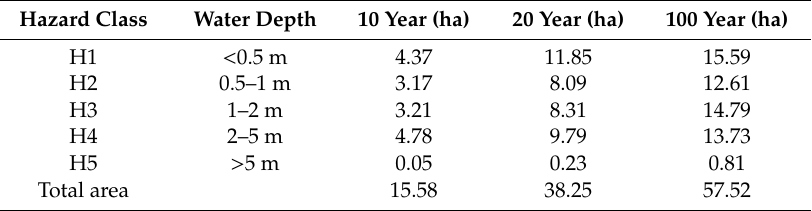
Table 8. Areas affected by the floods of different return periods for the settlement Arnasay (Classification 1).